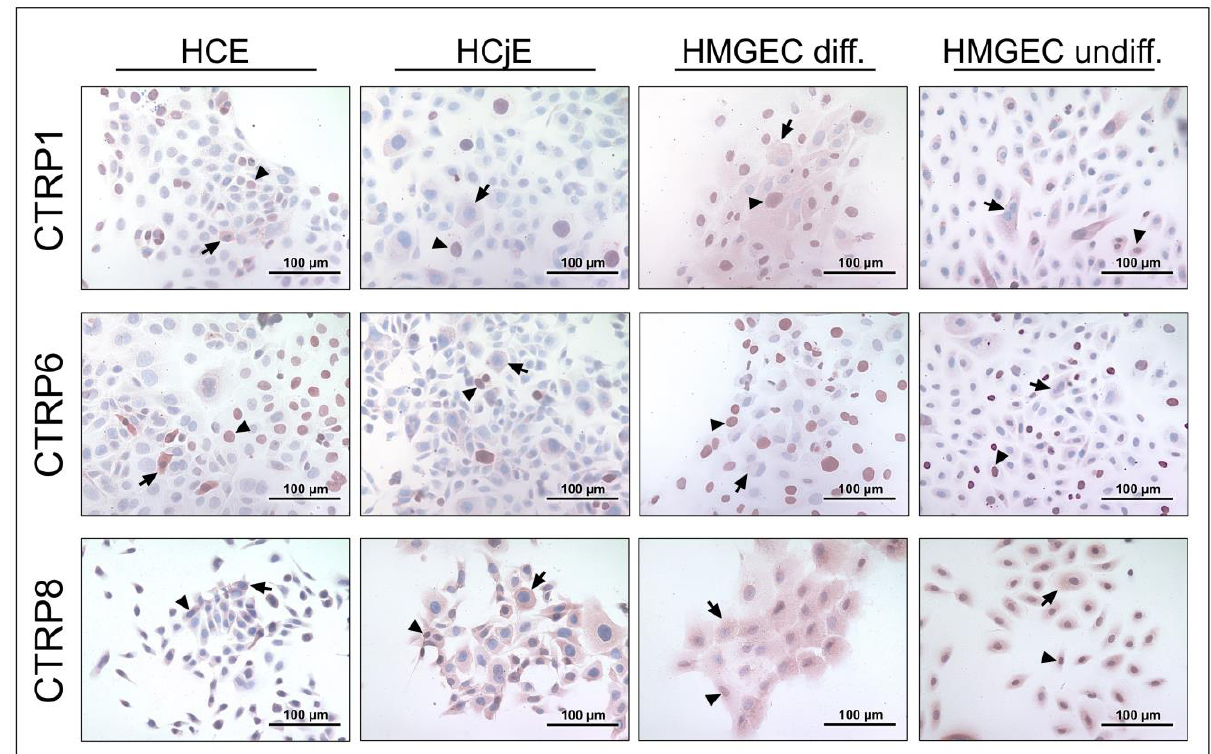
Figure 3. Immunohistochemical detection of CTRP1, CTRP6, and CTRP8 in cell lines of the hu- man lacrimal apparatus and ocular surface. The antibody reaction can be seen by the intracellular red reactivity. Pictures shown are representative for human corneal epithelial cells (HCE), human conjunctival epithelial cells (HCjE), differentiated human meibomian gland epithelial cells (HMGEC), and undifferentiated HMGEC. Nuclei are counterstained with hemalum (blue). Arrows and arrowheads accentuate the reactivity localization. For each cell line, three individual experiments were performed.